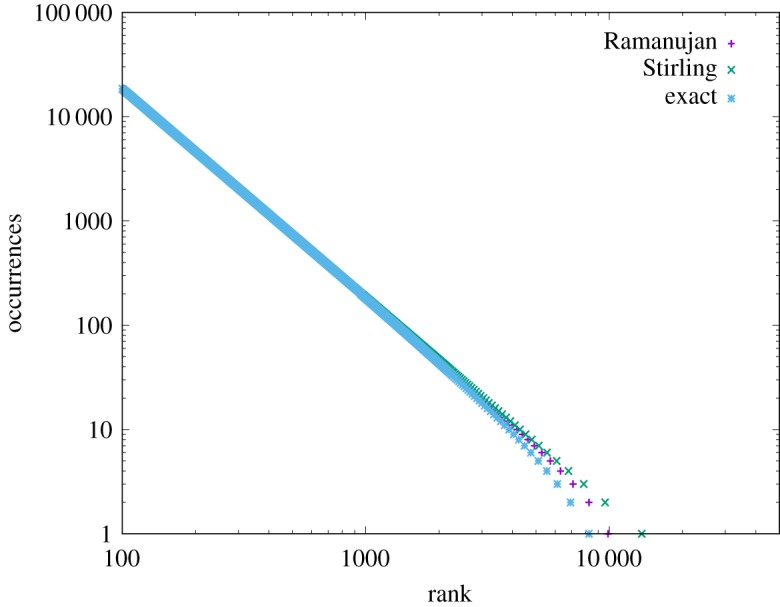
Illustrating a typical CoHSI homogeneous solution for three different approximations to the log factorial. As can be seen, handling the sparsely populated bins correctly leads to a natural droop in the predicted power law.